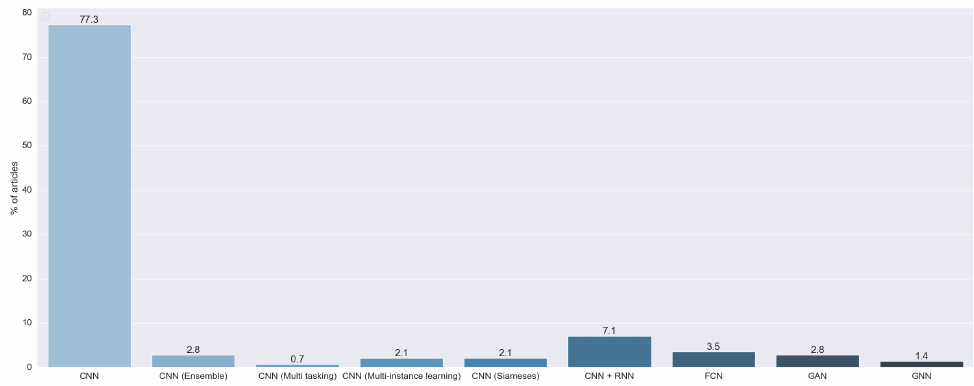
Figure 7. Answers to RQ2. Vertical axis indicates the percentage of articles for each